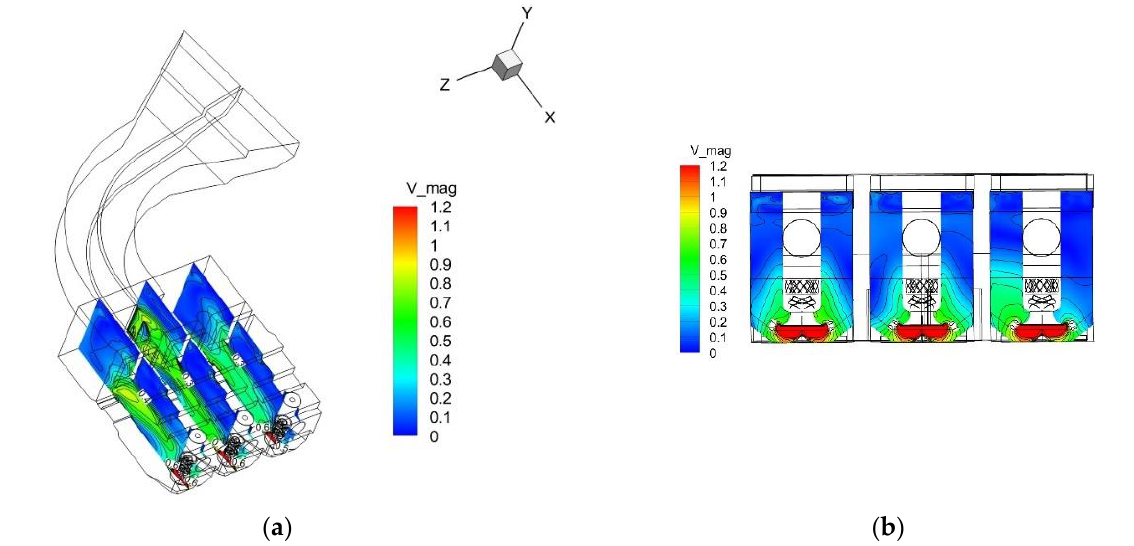
Figure 17. Plan 9 Isogram of velocity. ( a ) Center section of pump body along flow direction. ( b ) Center section of pump body in vertical flow direction.